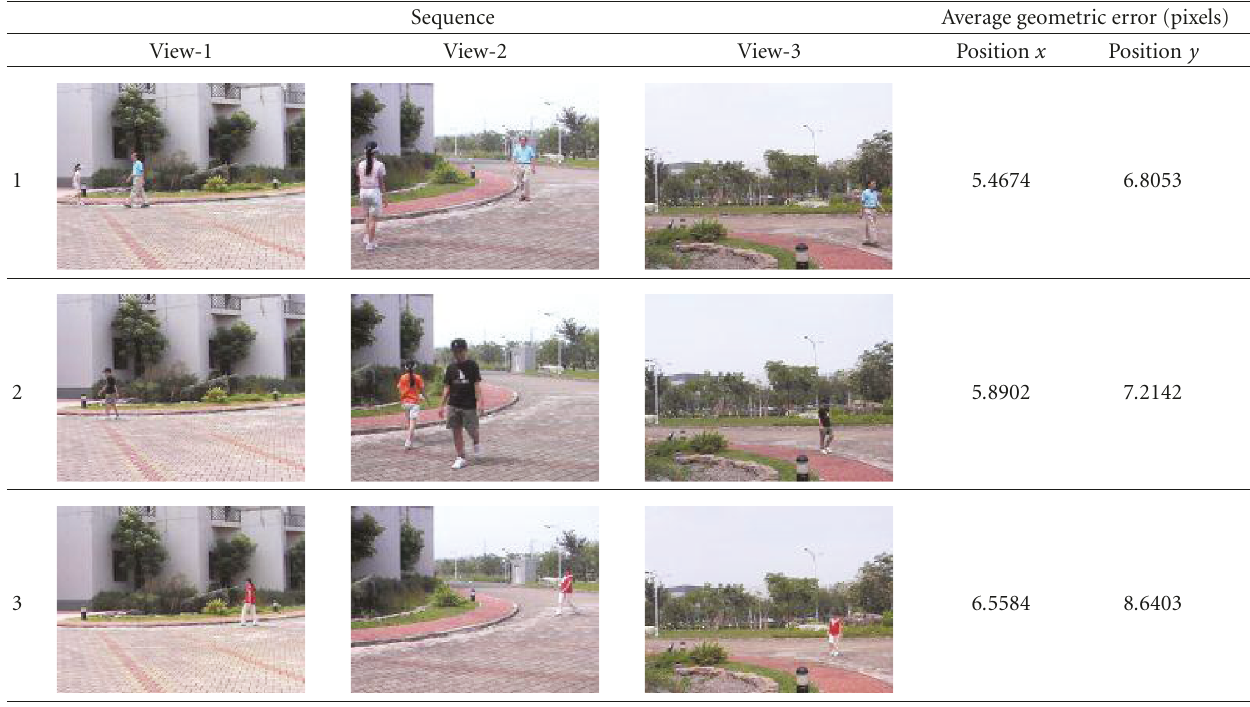
Table 1: Average geometric error for test sequences.